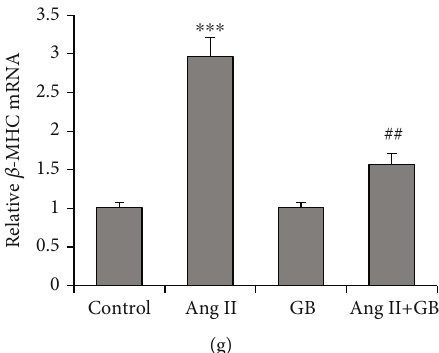
Figure 1: Ginkgolide B attenuates Ang II-induced hypertrophy. H9c2 cells were incubated with Ang II (0, 0.1, 1, and 10 μ M) for 48h. RT- qPCR examined (a) ANP and (b) β -MHC mRNA levels. (c) Cell viability assay (cells were incubated for 48 h) showed the Ginkgolide B with above 50 μ M has an obvious toxic e ff ect on cardiomyocytes. (d) H9c2 cells were pretreated with Ginkgolide B (30 μ M) for 2 h and then incubated with Ang II (1 μ M) for a further 48 h. Representative photographs are shown (scale bar: 5 μ m). (e) Cardiomyocyte hypertrophy is evaluated by quantifying cell surface area. mRNA expressions of ANP (f) and β -MHC (g) were evaluated by real-time PCR. Data were presented as the mean ± SD . ∗ P < 0 : 05 , ∗∗∗ P < 0 : 001 vs. the control group; # P < 0 : 05 , ## P < 0 : 01 , and ### P < 0 : 001 vs. the Ang II